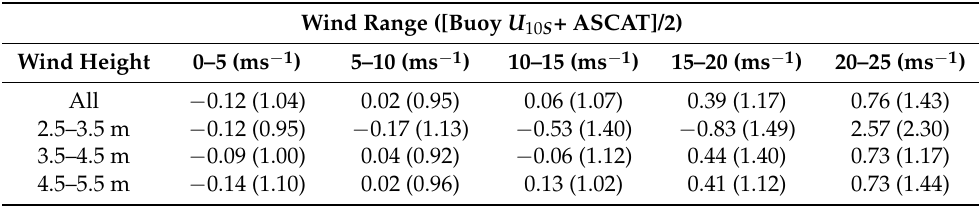
Table 2. Average and standard deviation (in parenthesis) of wind residuals (buoy U 10 S − ASCAT) grouped by anemometer height and organized by averages of buoy U 10 S and